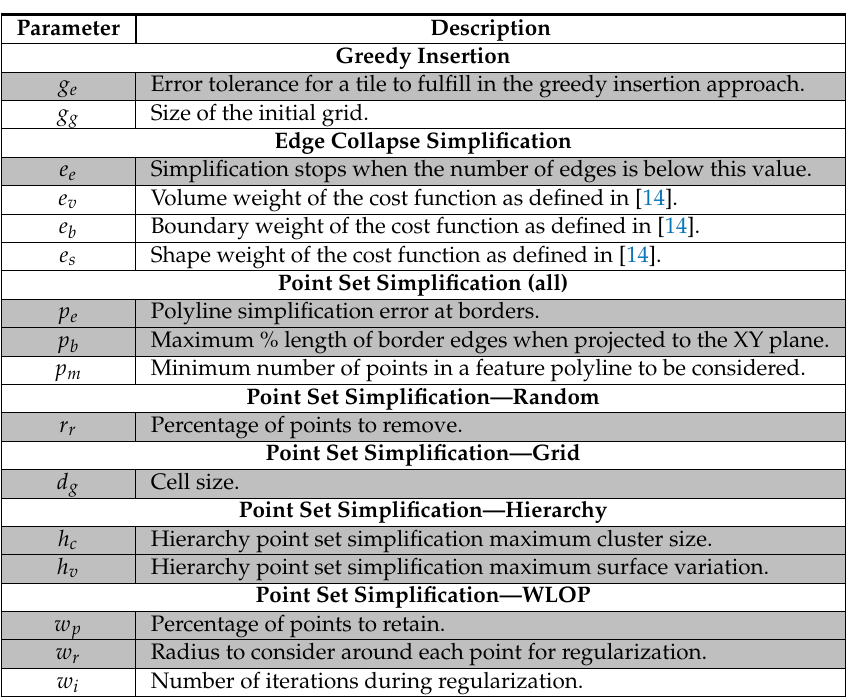
Table 1. A list and description of the parameters that need to be set for each method. Those highlighted in gray need to be set for each zoom, and are set using the method described in Section